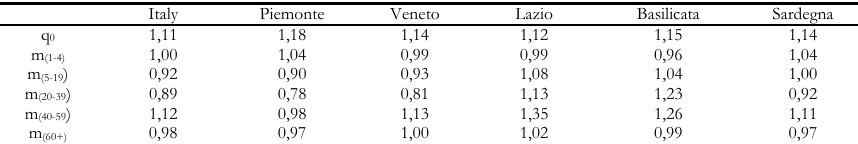
Ratios between male and female age specific mortality rates in Italy and in some selected regions (1881-1882) Italy Piemonte Veneto Lazio Basilicata Sardegna q 0 1,11